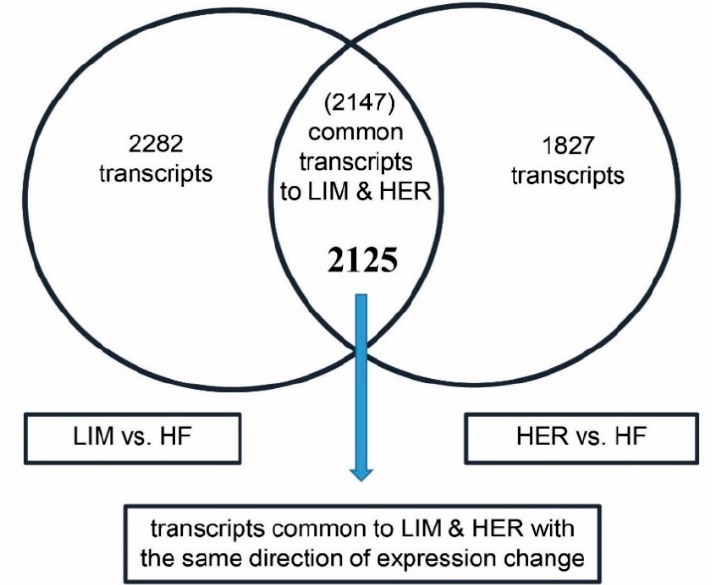
Figure 1. The number of transcripts identified as part of the comparison between primary cultures of semitendinosus muscle cells of beef breeds (Limousin (LIM) and Hereford (HER)) relative to the dairy breed (Holstein-Friesian (HF)), showing statistically significant di ff erences in expression ( p ≤ 0.05; fold change (FC) ≥ 1.3) ( n = 4 for each breed).